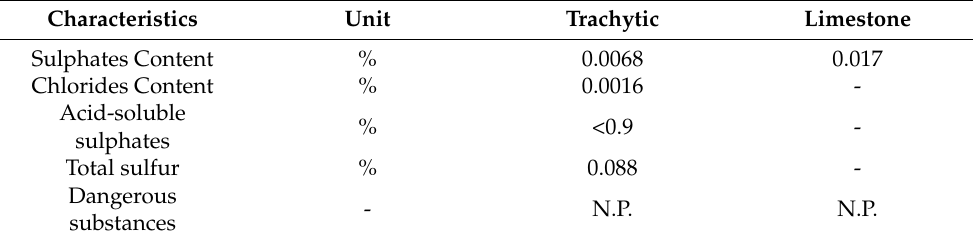
Table 2. The average chemical composition of the selected aggregates. Characteristics Unit Trachytic Limestone Sulphates